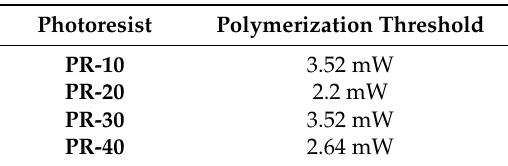
Table 2. Photoresist polymerization thresholds.